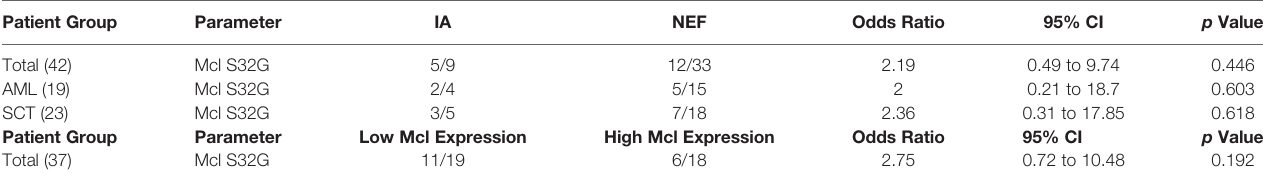
TABLE 2 | Mcl S32G does not affect Mcl gene expression or the incidence of